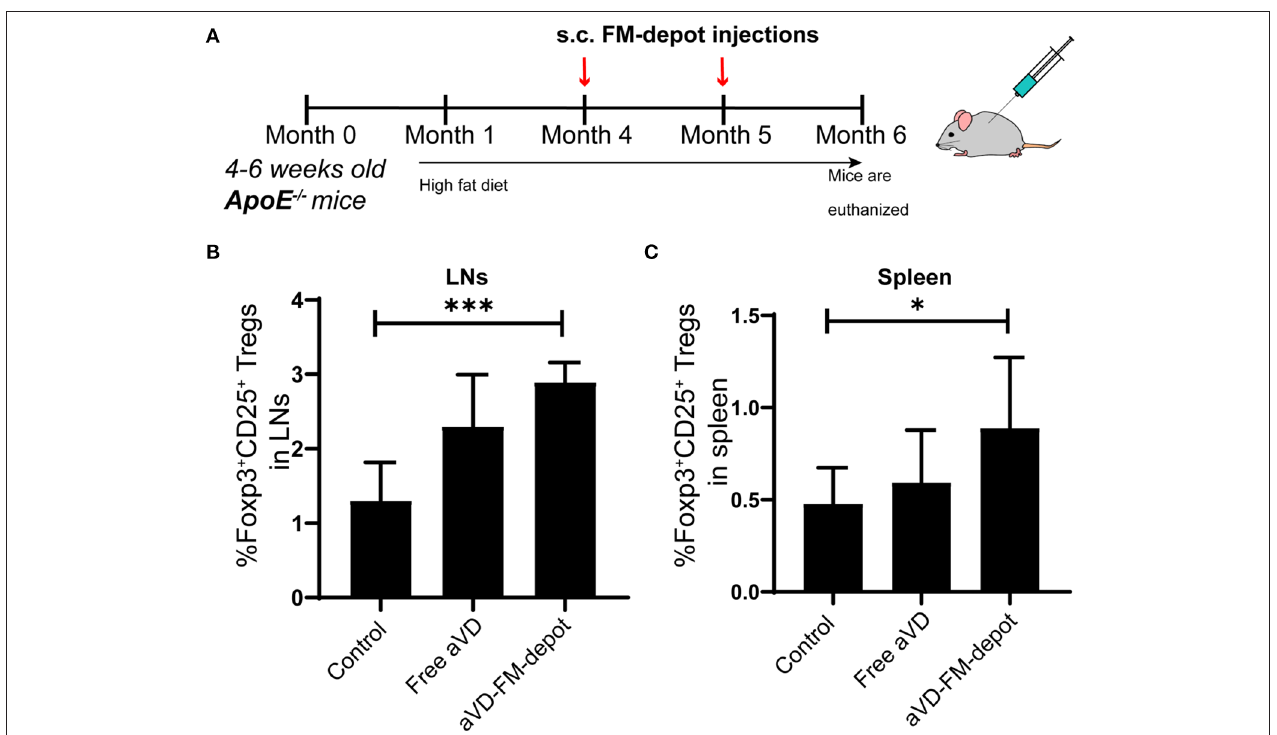
FIGURE 4 | aVD-loaded FM-depots elicit Treg responses in lymph nodes and spleen of ApoE − / − mice. (A) Schematic diagram outlining the experimental design for inducing Tregs in ApoE − / − mice. Ten-week old mice were fed with high fat diet for 3 months and then s.c. injected with PBS, free aVD, and aVD-loaded FM-depots monthly. Flow cytometric analysis showed the percentages of Foxp3 + Tregs (Foxp3 + CD25 + CD4 + ) gated on CD45 + CD3 + live cells in the spleen (B) and lymph nodes (LNs) (C) of ApoE − / − mice. N = 5–8 mice per group. Two-tailed t -tests were used for statistical significance: * p < 0.05, *** p < 0.001.